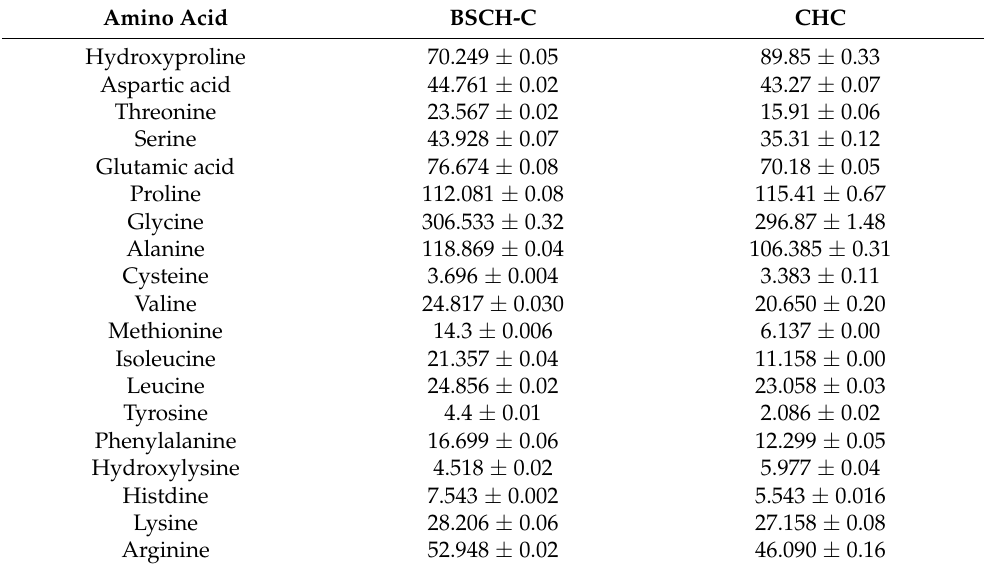
Table 4. Amino acid composition of BSCH-C and CHC. Values are expressed in residues per 1000 residues.